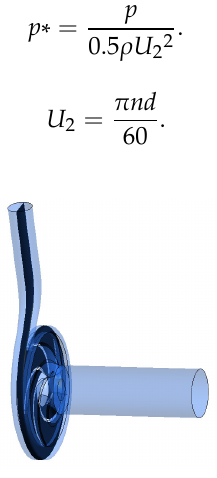
Figure 7. Middle section.